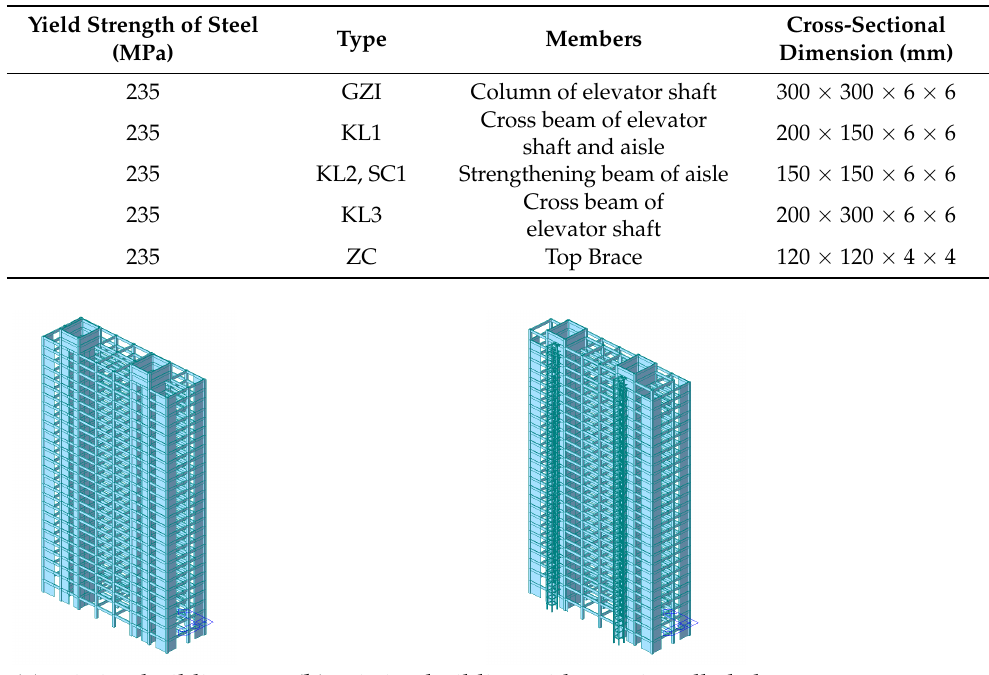
Table 1. Material parameters of post-installed elevator. Yield Strength of Steel